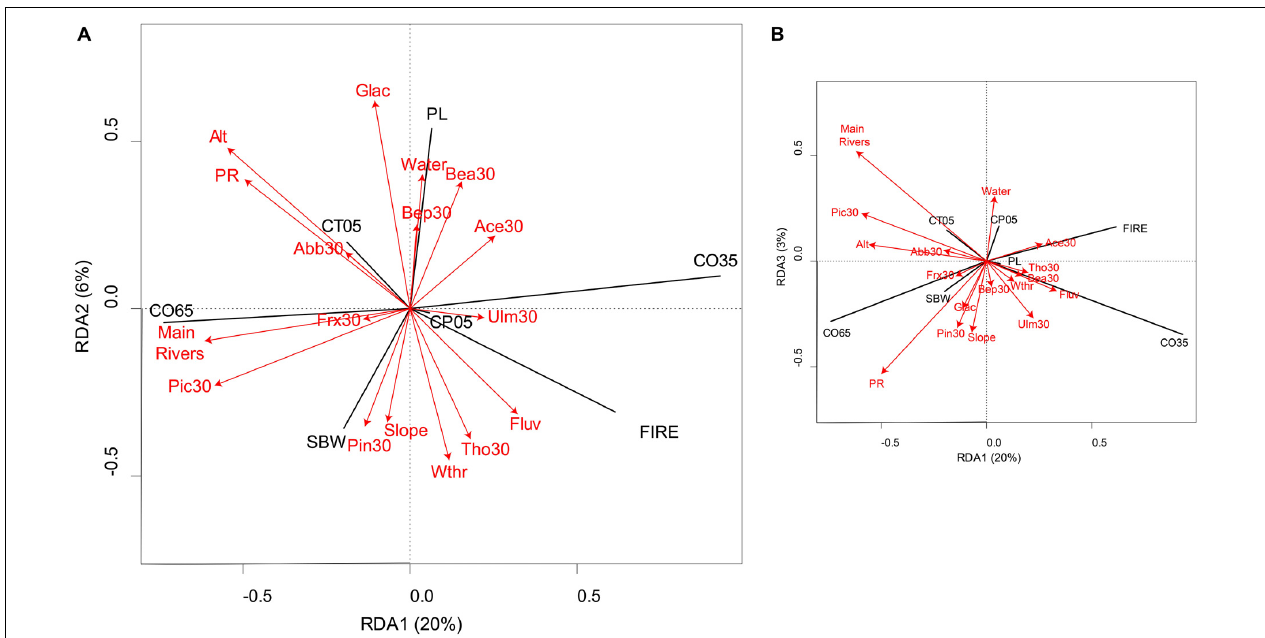
FIGURE 5 | Redundancy analysis (model adjusted R2 = 32%) of the 20th century disturbances (black lines) correlated to 17 explanatory variables (red vectors) in two driver sets (environmental variables and taxa basal area in 1930). Projections showed using (A) first and second ordination axes, and (B) first and third ordination axes. N = 333 cells of 3 × 3 km. FIRE: Fire (1895–2005), PL: Plantations (1955–2005), SBW: Spruce Budworm outbreaks (1975–2005), CO35: Cut over (1895–1935), CO65: Cut over (1935–1965), CP05: Partial cut (1965–2005), CT05: Clear cut (1965–2005). Acronyms of explanatory variables are indicated in the Table 4 .